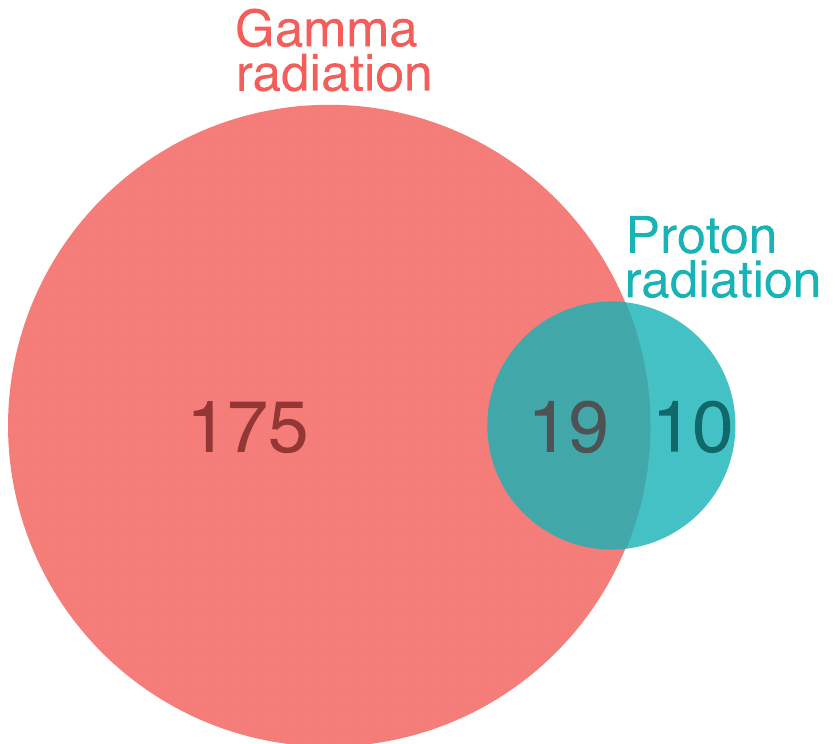
Fig 2. Comparison of the number of dose-responsive genes. A Venn-diagram of genes that present a dose- dependent increase in expression in response to gamma and proton radiation at q -value � 0.1 is shown.